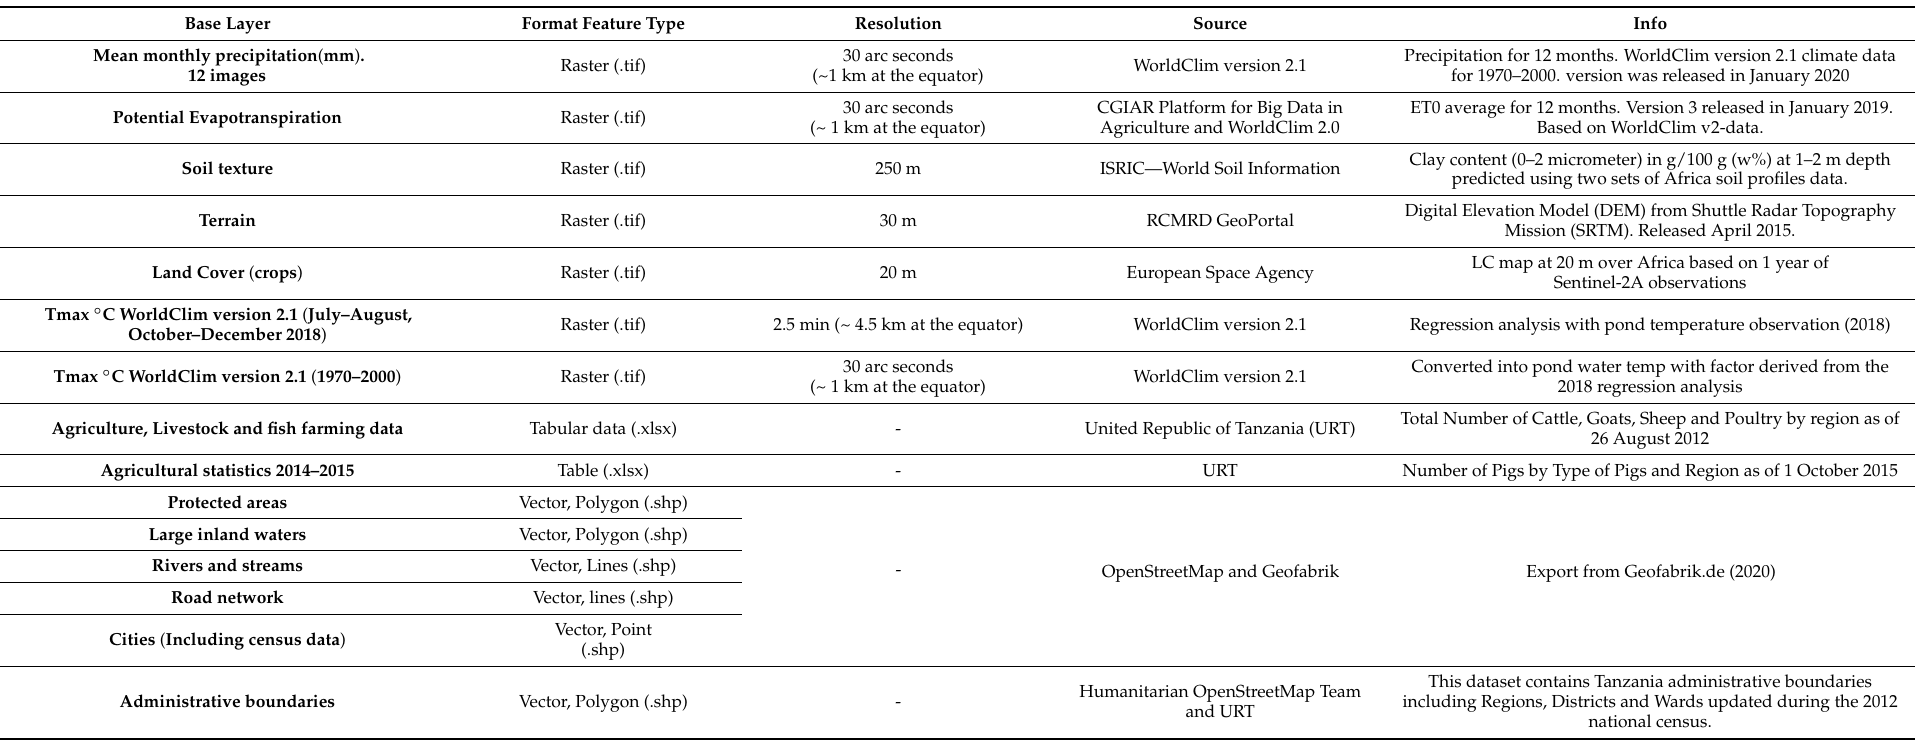
Table A1. Compilation of the input data derived for the spatial